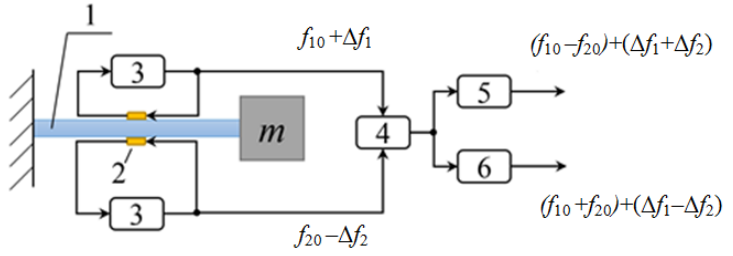
Figure 4. Operational scheme of the SAW accelerometer. Figure adapted from [12].